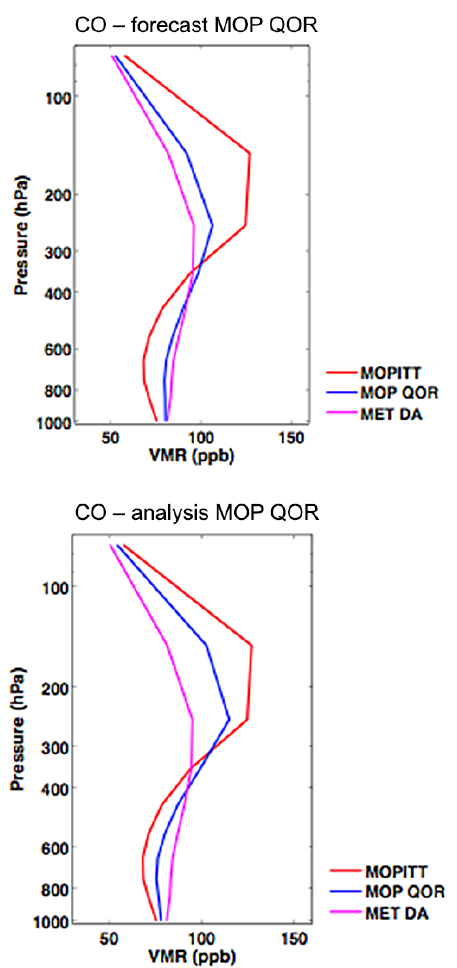
Figure 3. Vertical profiles of time/horizontal domain average CO from the MOP QOR and MET DA experiments for 00:00UTC, 25– 29 June 2008. The results are in MOPTT retrieval space. The red profiles represent the MOPITT retrievals. Otherwise the color of the lines corresponds to the legend. forecast is the assimilation prior, and analysis is the assimilation